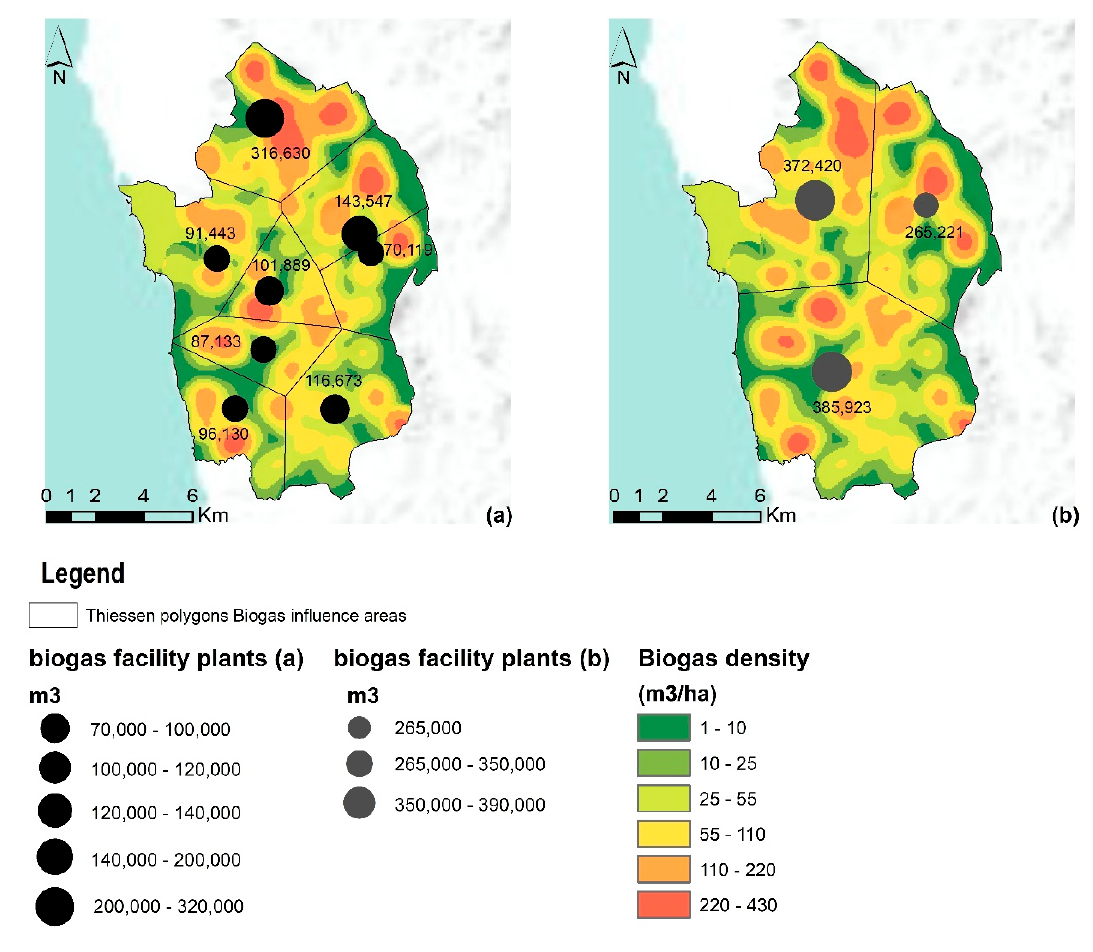
Figure 6. Resource Allocation, Areas of Influence and Energy Capacity of the Biogas Facilities in the Two Scenarios .